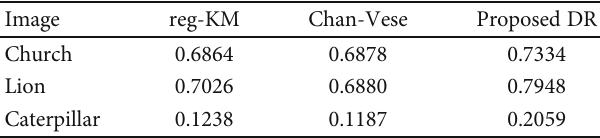
Table 2: Comparison of reg-KM, Chan-Vese algorithm, and proposed DR algorithm in terms of SSIM.